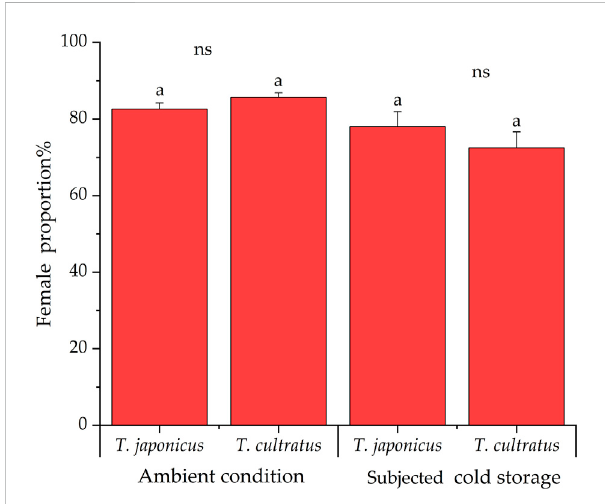
FIGURE 2 Proportion of females produced by T. japonicus and T. cultratus under ambient rearing conditions (25 ° C) and after cold storage for 19 weeks at 11 ° C for offspring. Same marked by lowercase letters represent no signi fi cant differences for each parasitoid species between ambient and after cold storage ( p > 0.05), and ns denotes no signi fi cant difference between T. japonicus and T. cultratus within the same